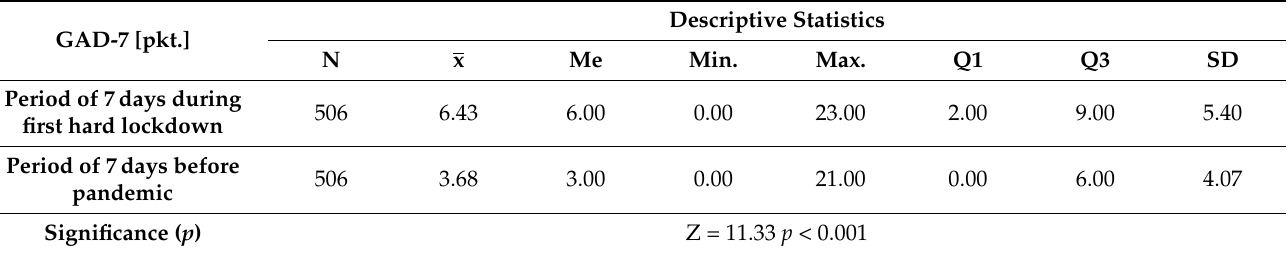
Table 3. The level of generalised anxiety before and during the